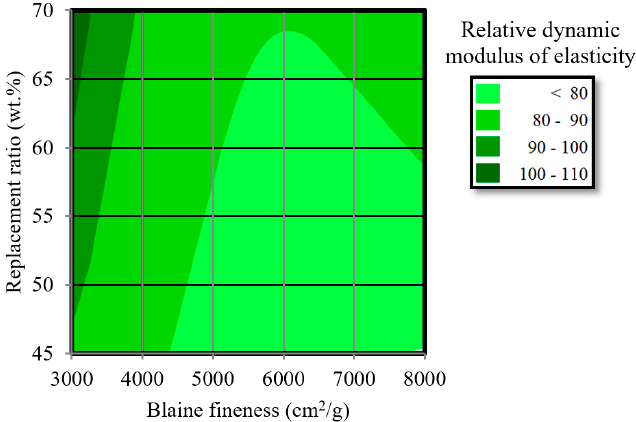
Figure 15. Contour plot of the optimum fineness and replacement ratio for BFS.